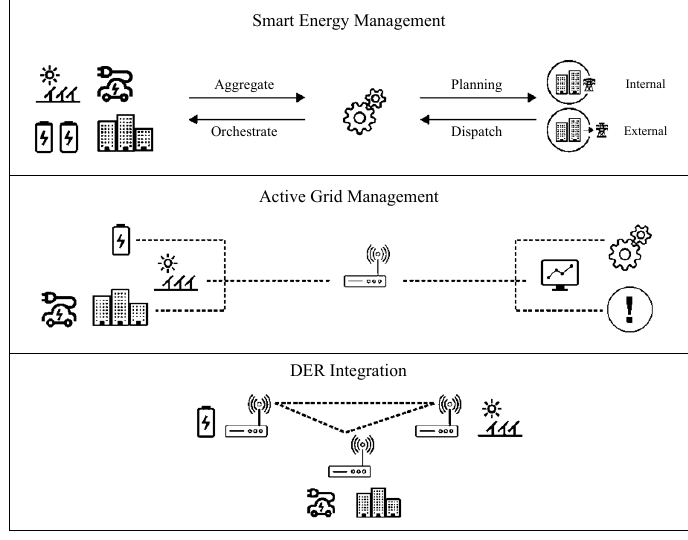
Figure 4. Smart Microgrid